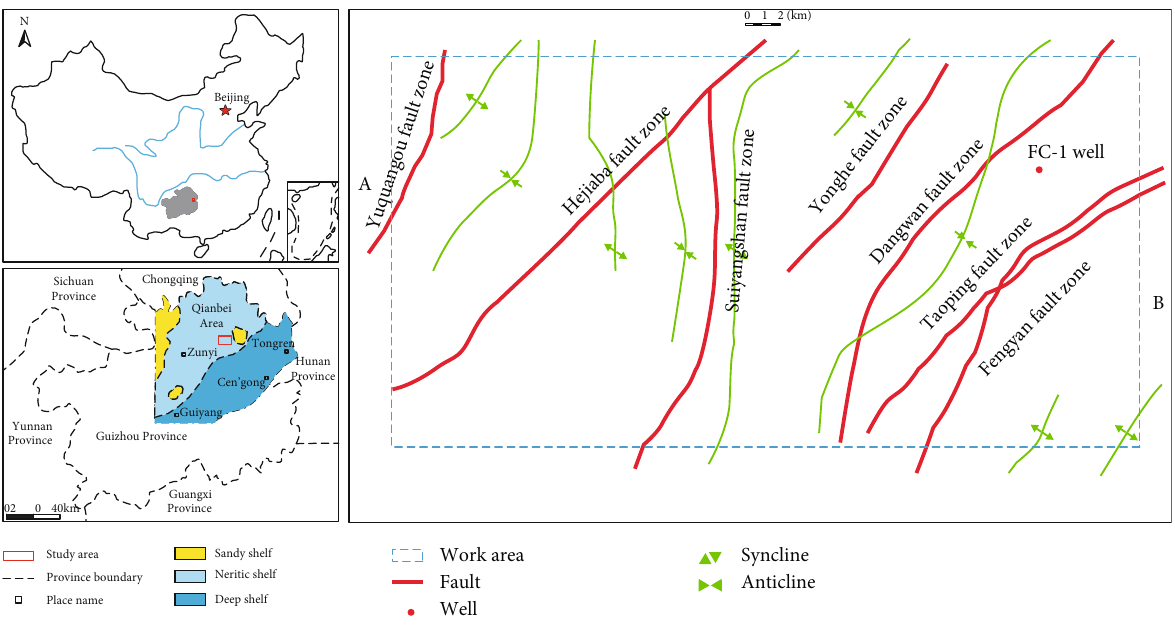
Figure 1: Area map of the third block of Fenggang, Qianbei,